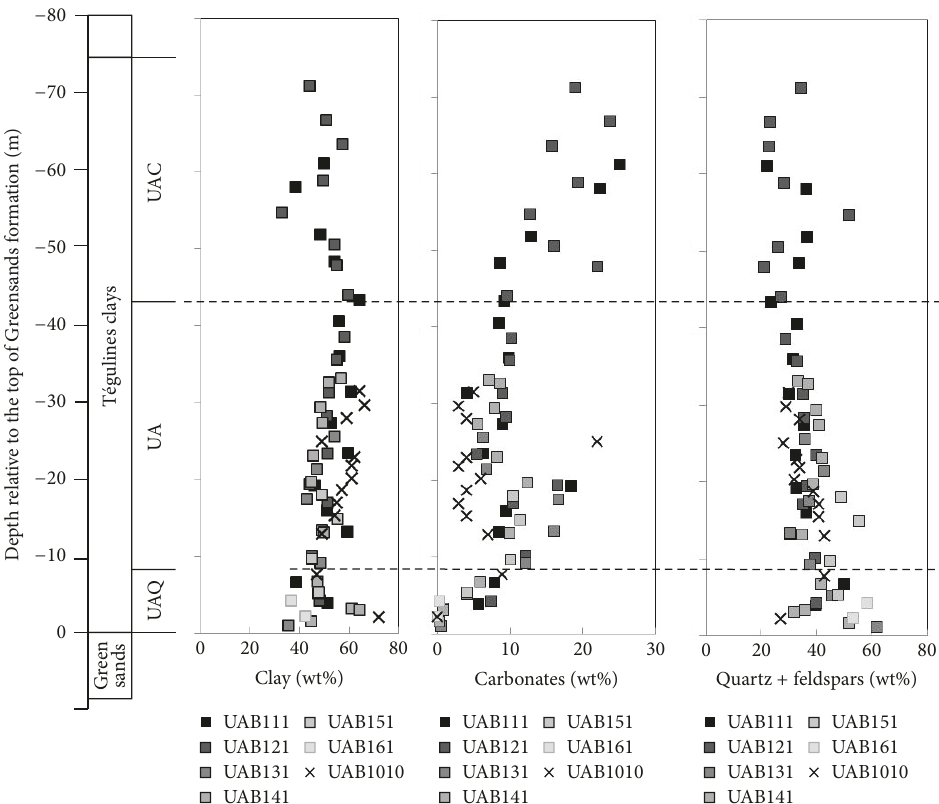
Figure 2: Profiles of clay, carbonates, and (quartz + K-feldspar) silty contents as a function of depth relative to the top of Greensands. Dashed lines indicate the limits of the three units defined in the T´egulines